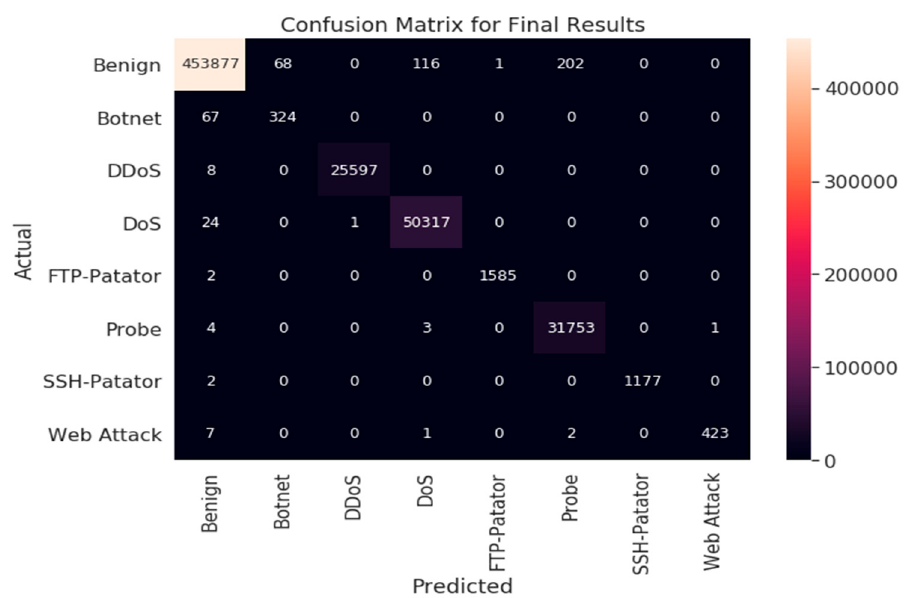
Figure 4. Binary-class confusion matrix.